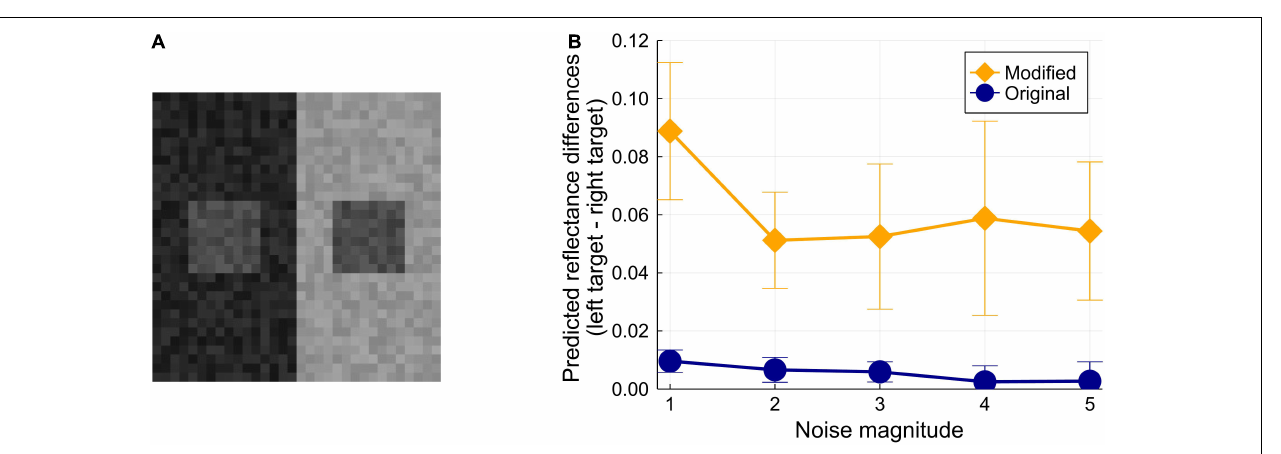
FIGURE 4 | (A) Example of a noised image. In this example, the lower and upper limits of the uniform distribution are ± 5. The SLC effect should be present in most observation environments. (B) Results of the test for the noise’s influence on the model predictions. Each error bar represents the standard deviation of 10 tests in each